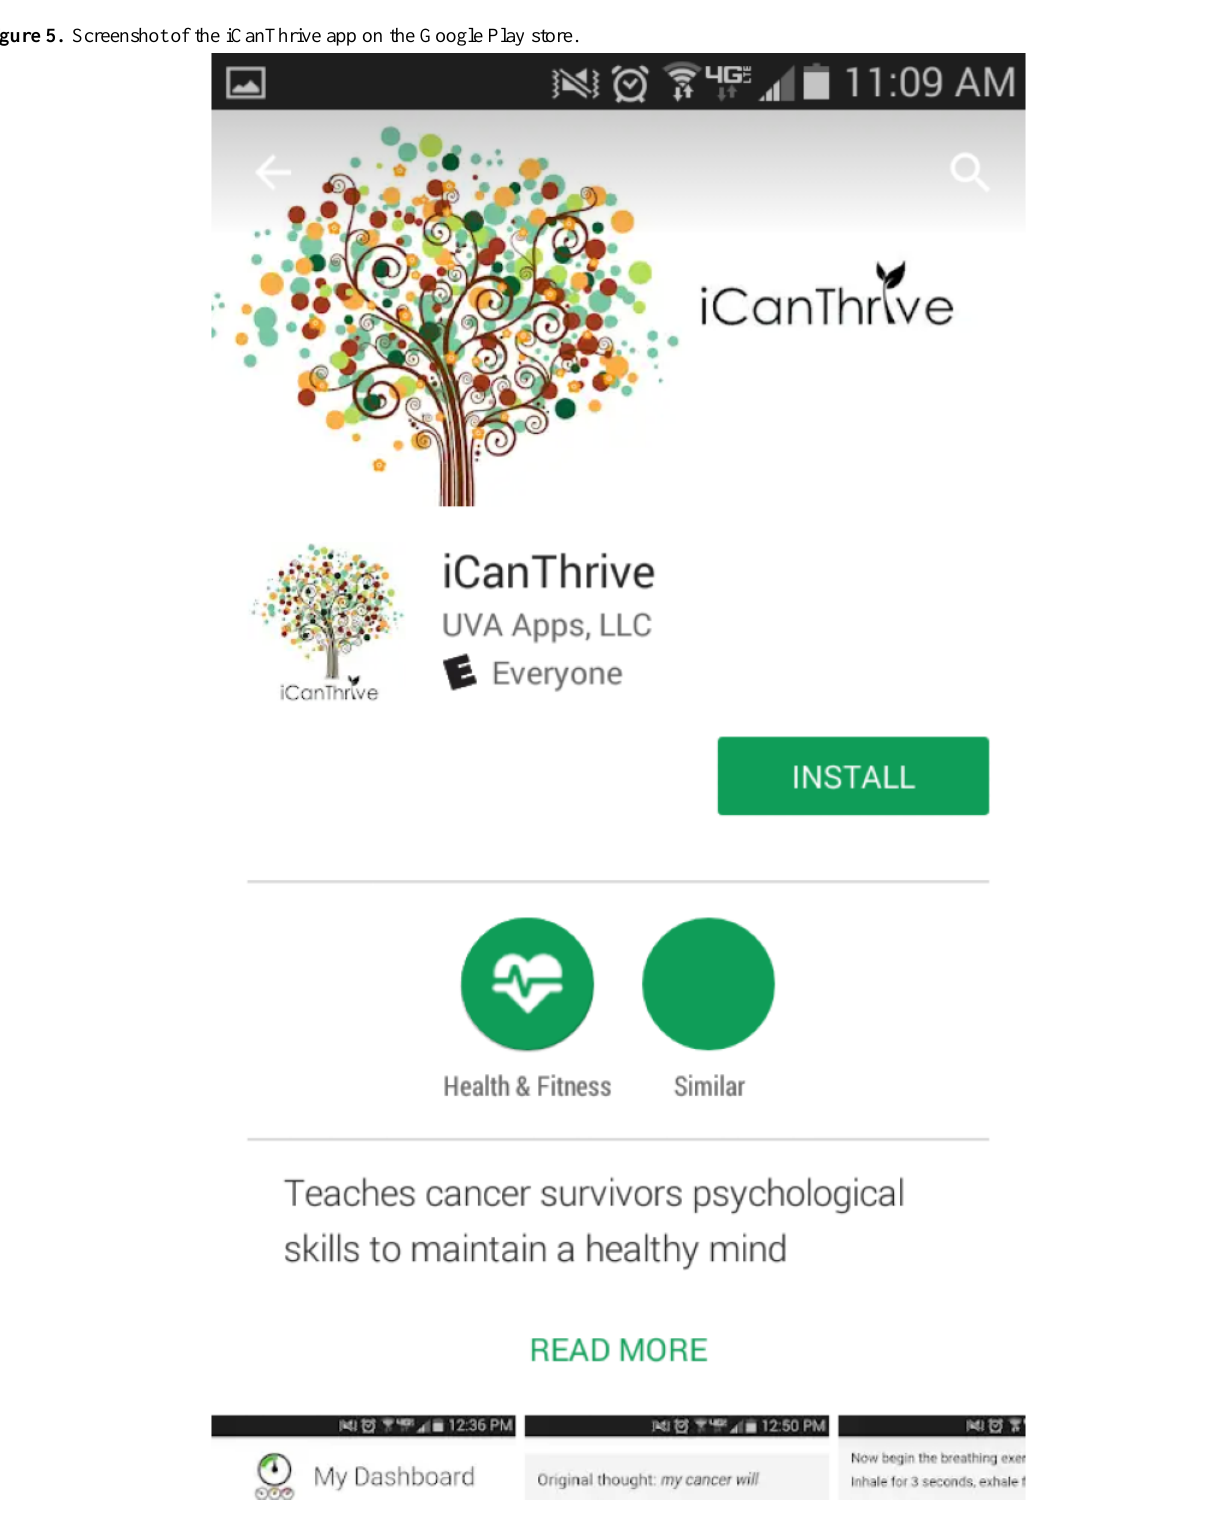
Figure 5. Screenshot of the iCanThrive app on the Google Play